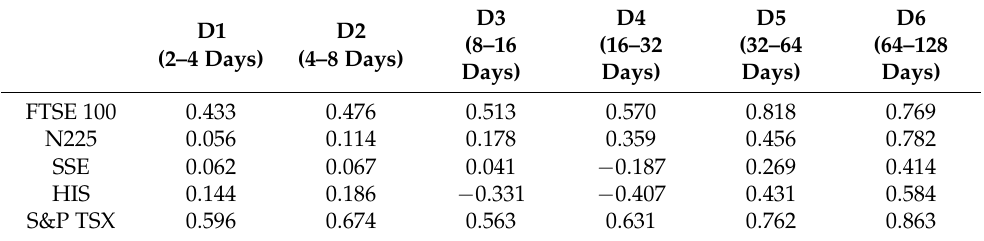
Table 3. WC-GARCH-GJR (1,1) estimation results before the COVID-19 outbreak.